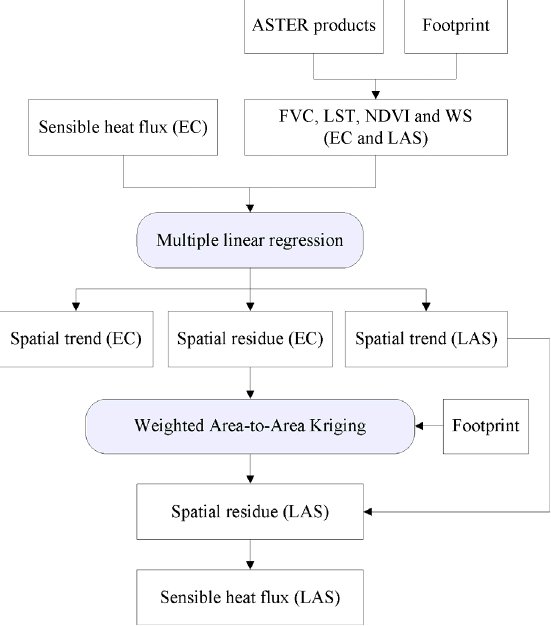
Figure 2. Process flowchart of WATA RK for sensible heat